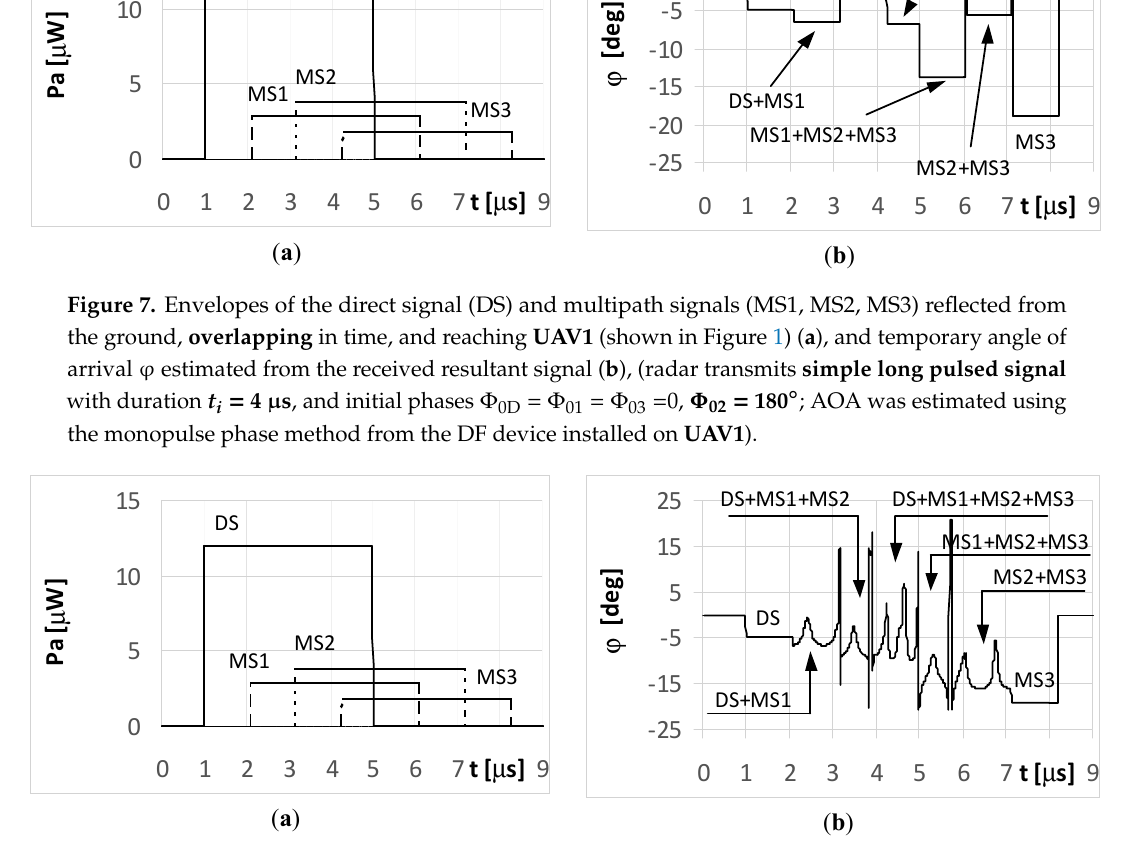
Figure 8. Envelopes of the direct signal (DS) and multipath signals (MS1, MS2, MS3) reflected from the ground, overlapping in time, and reaching UAV1 (shown in Figure 1) ( a ), and temporary angle of arrival ϕ estimated from the received resultant signal ( b ), (radar transmits LFM-type long pulsed signal with duration t i = 4 µ s , initial phases Φ 0D = Φ 01 = Φ 02 = Φ 03 = 0 ◦ , and deviation ∆ f = 5 MHz; AOA was estimated using the monopulse phase method from the DF device installed on UAV1 ).